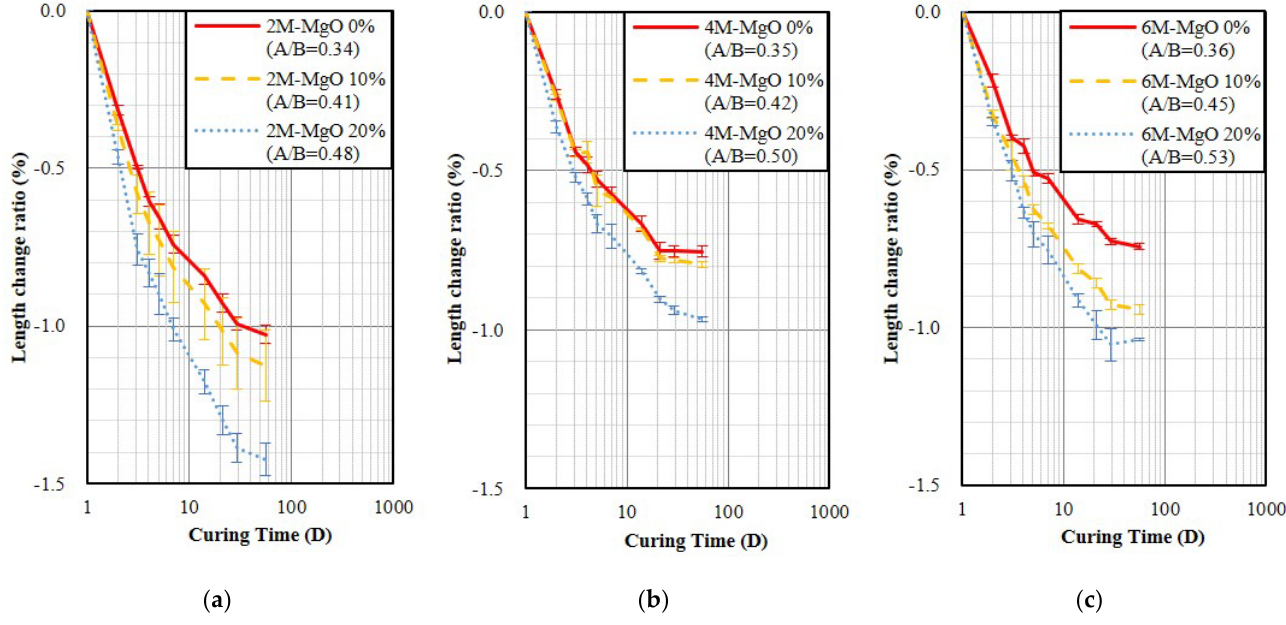
Figure 5. The length change ratios of the GP specimens fixed fluidity and demold at age of 3 h and